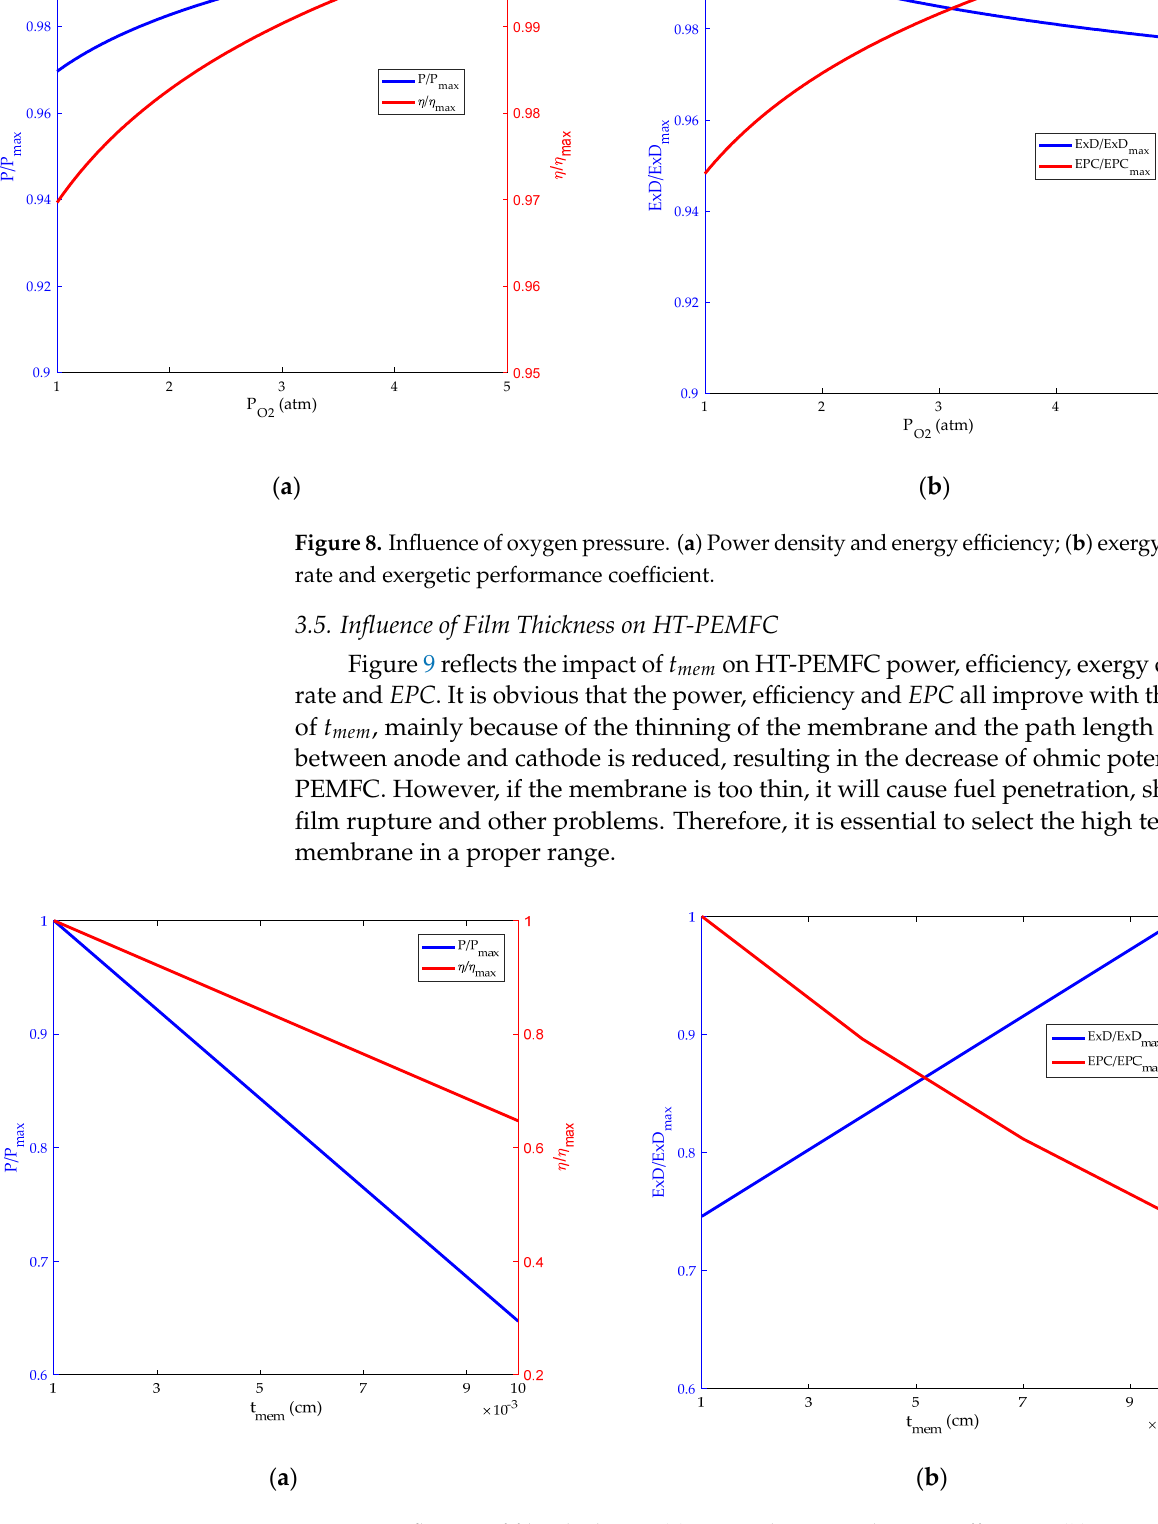
Figure 7. Influence of hydrogen pressure. ( a ) Power density and energy efficiency; ( b ) exergy de- struction rate and exergetic performance coefficient.